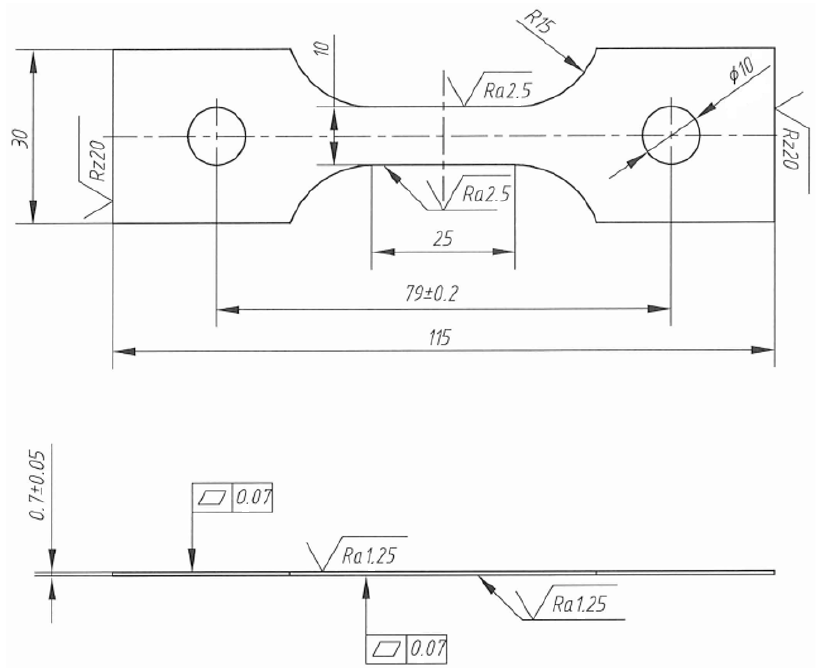
Figure 2. Configuration of tensile test pieces used in this study.